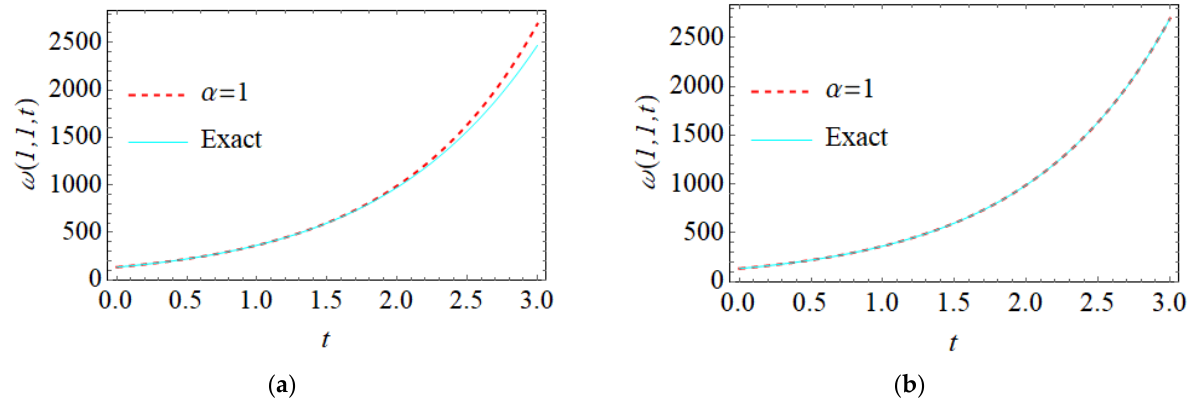
Figure 5. The behavior of exact versus j -th analytical approximate solutions for all t ∈ [ 0,3 ] , ( a ) For j = 5; ( b ) For j =